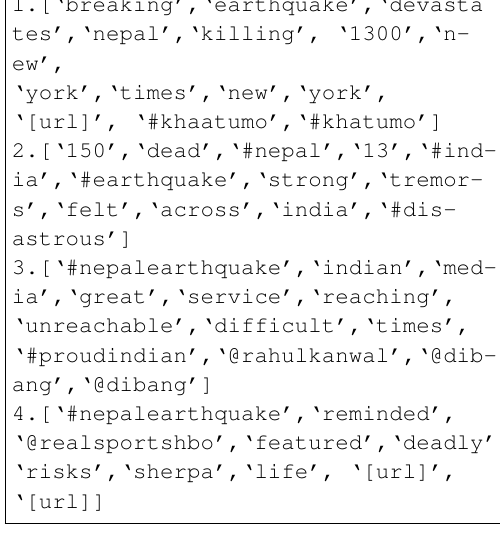
Fig. 2 Output of pre-processing.